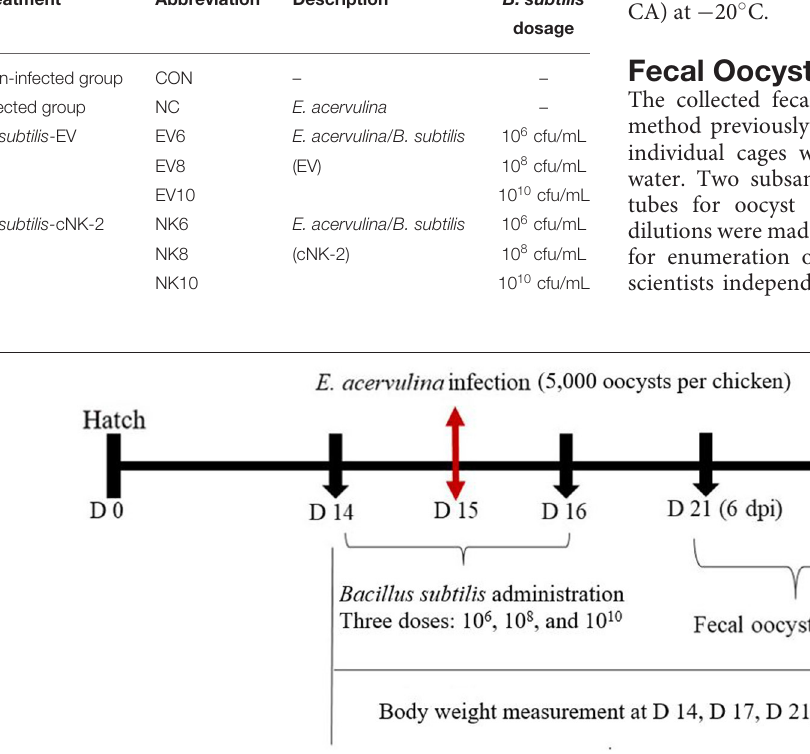
FIGURE 1 | Schematic outline of the experimental